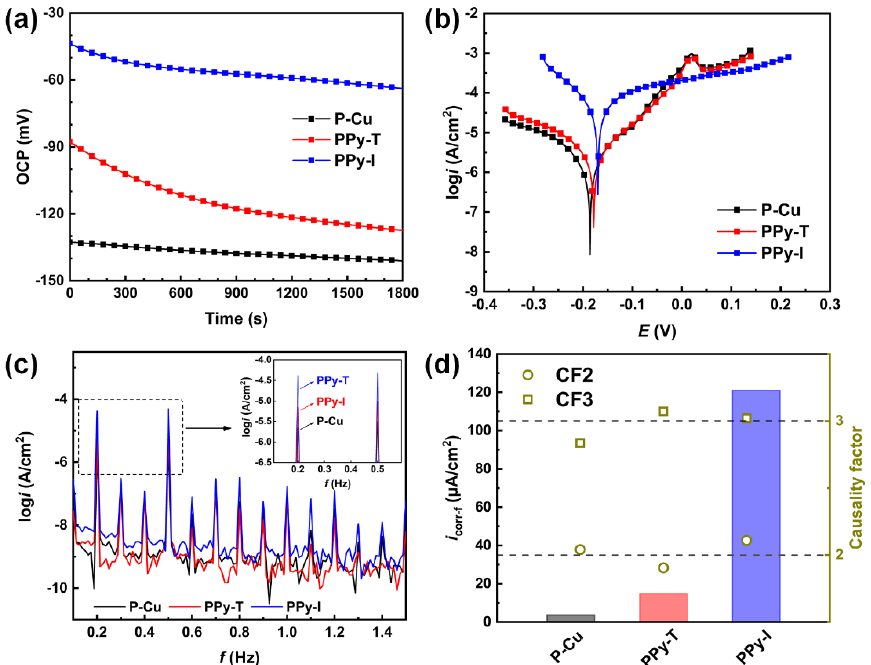
Figure 4. OCP with time ( a ), polarization curves ( b ), EFM spectra ( c ) and the corresponding kinetic parameters ( d ) of passivated copper and PPy-T- and PPy-I-coated copper specimens after 24 h immersion in ASW at 298 K.